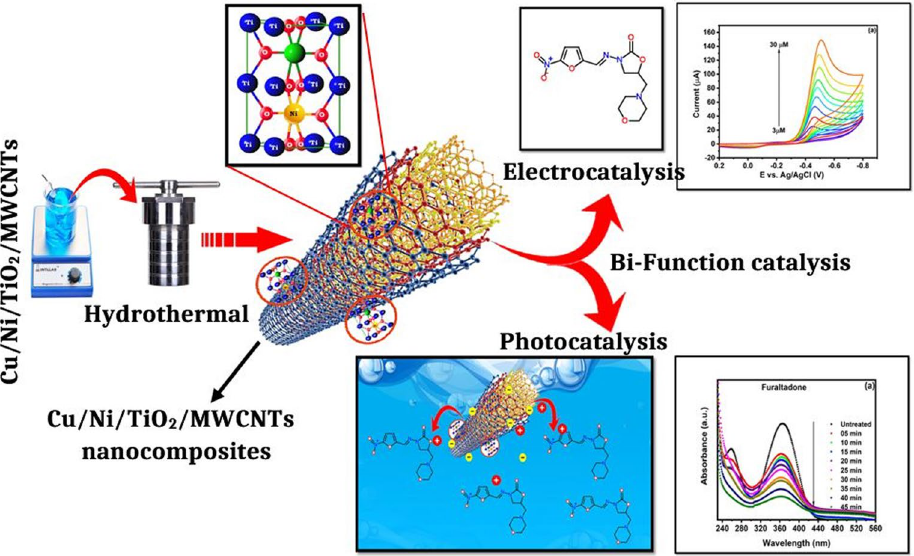
Figure 1. Schematic diagram for the synthesis of Cu/Ni/TiO 2 /MWCNTs nanocomposites and bi-functional applications.